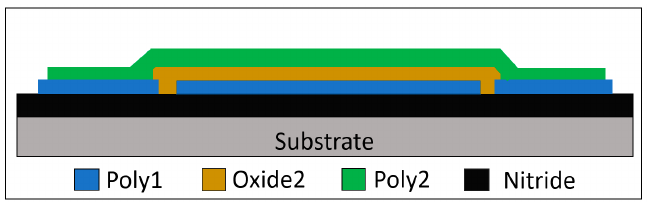
Figure 8. Cross-section of the micro-resonator with oxide as sacrificial layer.